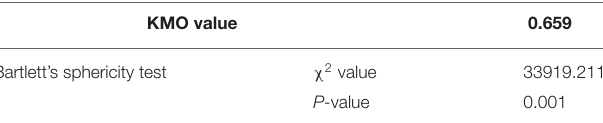
TABLE 2 | Validity test.